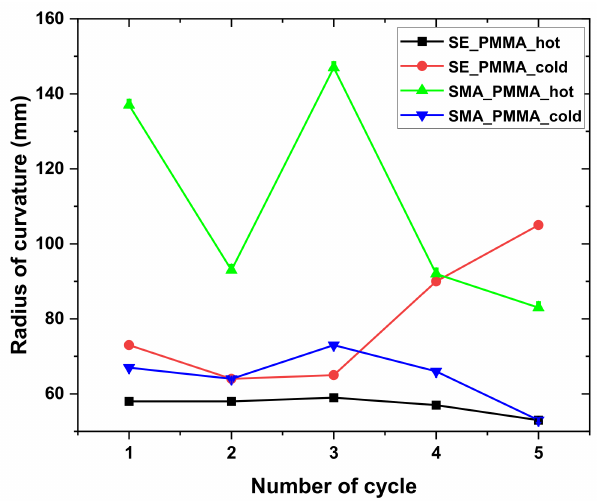
Figure 6. Shape recovery SE and SMA–PMMA composite ( a – d ) as the function of thermal cycles (heat, 100 ◦ C and cold, 0 ◦ C shape).